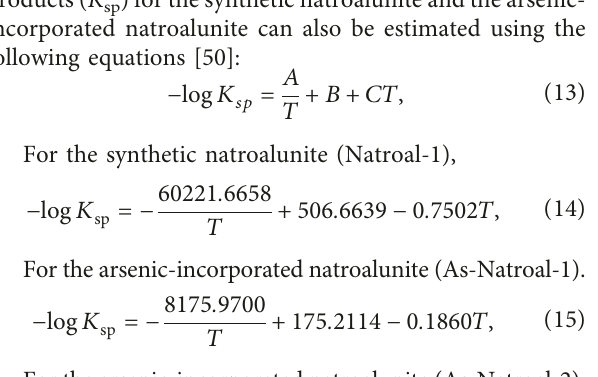
Table 2: Analytical data and solubility product of the arsenic-incorporated natroalunite [Na Analytical data Temp ( ° C) Initial pH Time (h)